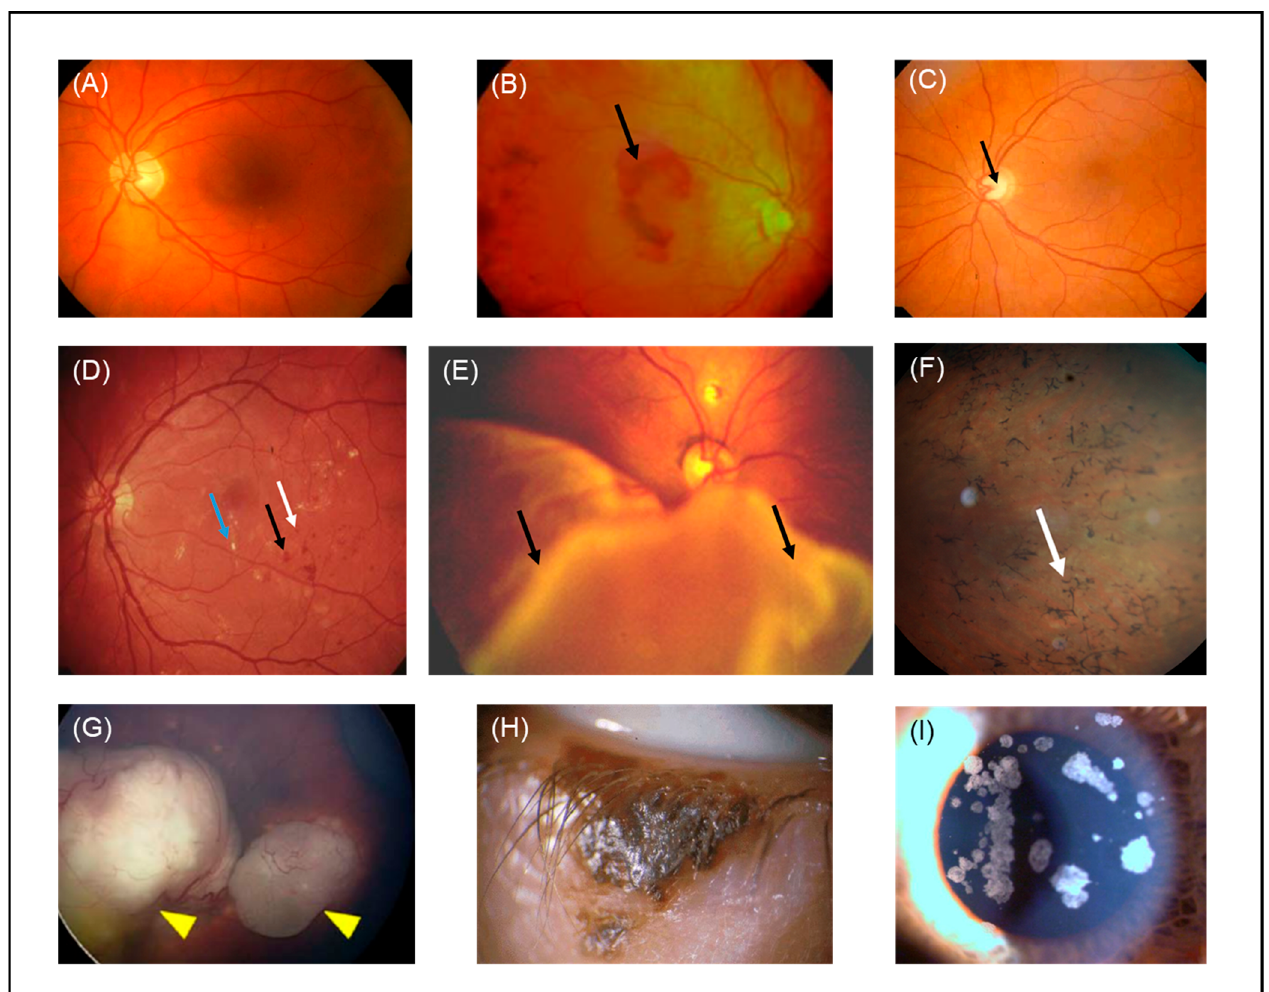
Figure 4. Color fundus photographs of ( A ) a healthy individual, ( B ) a patient with wet AMD (black arrow indicates hemorrhage, ( C ) a patient with glaucoma (black arrow indicates optic disc excavation), ( D ) a patient with DR (blue, black and white arrows indicate exudation, hemorrhage and microaneurysm, respectively), ( E ) a patient with retinal detachment (black arrows indicate PVR), ( F ) a patient with RP (white arrow indicates bone-spicule deposits), ( G ) a patient with RB (yellow arrowheads indicate tumors) adapted with permission from [148], John Wiley and Sons, 2018, ( H ) a patient with eyelid malignant melanoma. ( I ) Slit lamp image of a granular cornea dystrophy from a patient with corneal opacities. AMD: age-related macular degeneration, DR: diabetic retinopathy, PVR: proliferative vitreoretinopathy, RP: retinitis pigmentosa, RB: retinoblastoma .